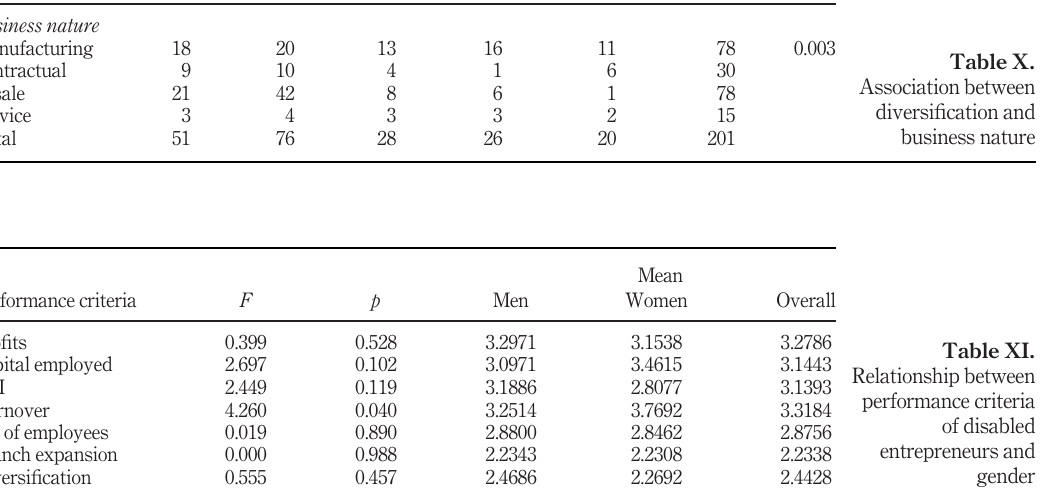
Table X. Association between